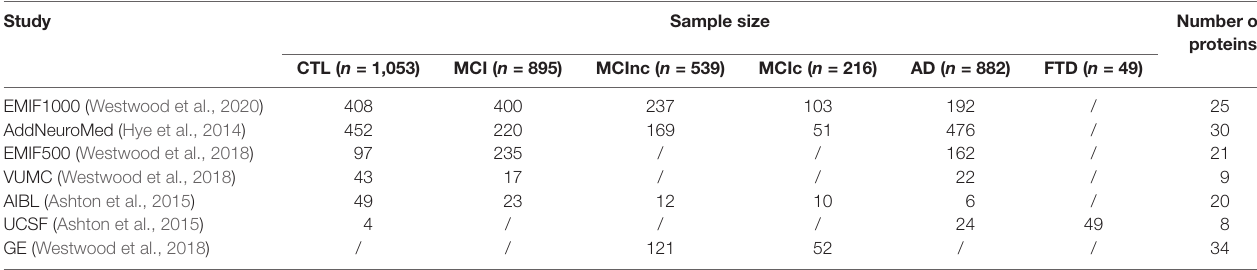
TABLE 1 | Description of subjects and the included studies in this